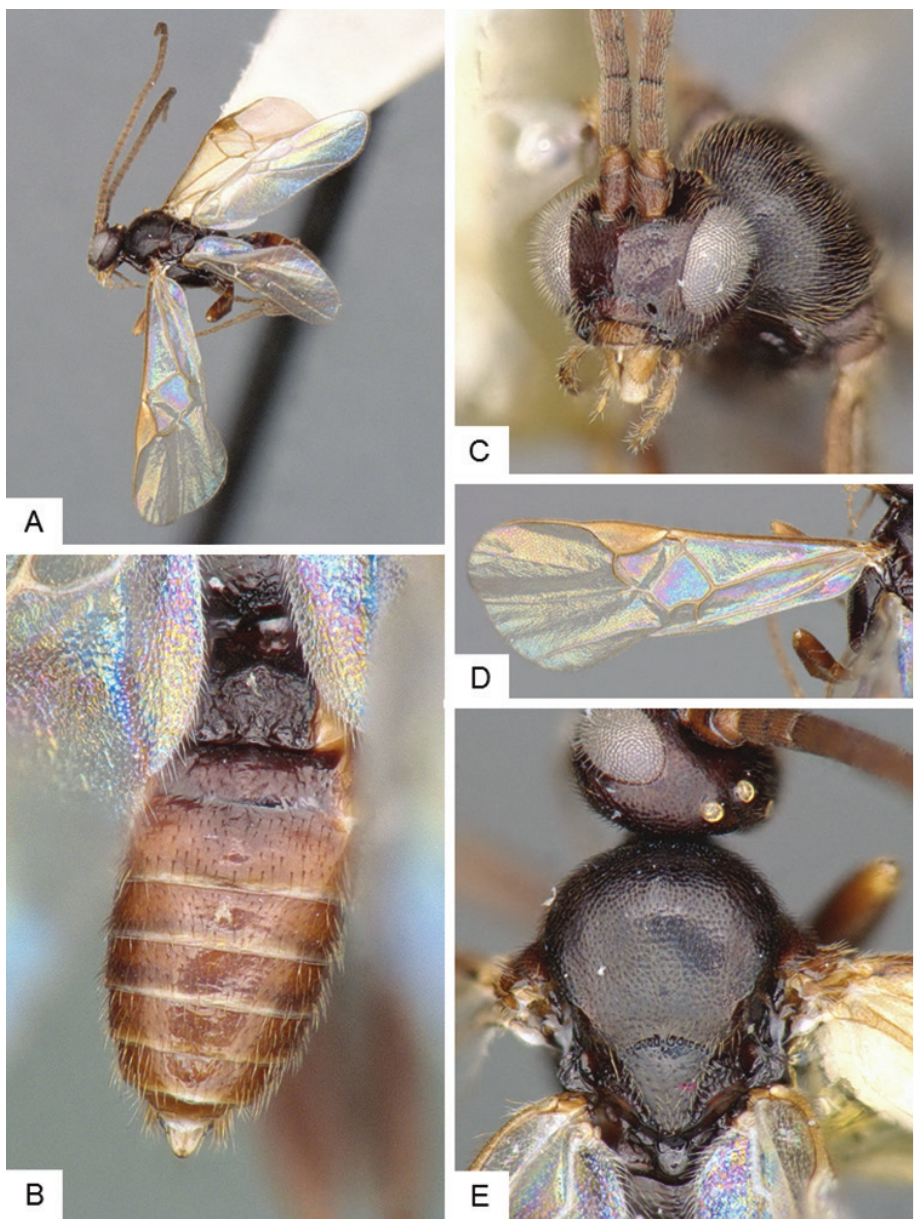
Figure 11. Dolichogenidea sp. 3. A Habitus lateral B Metasoma, dorsal C Head, frontal-lateral D Fore wing E Head (partially) and mesosoma (partially),